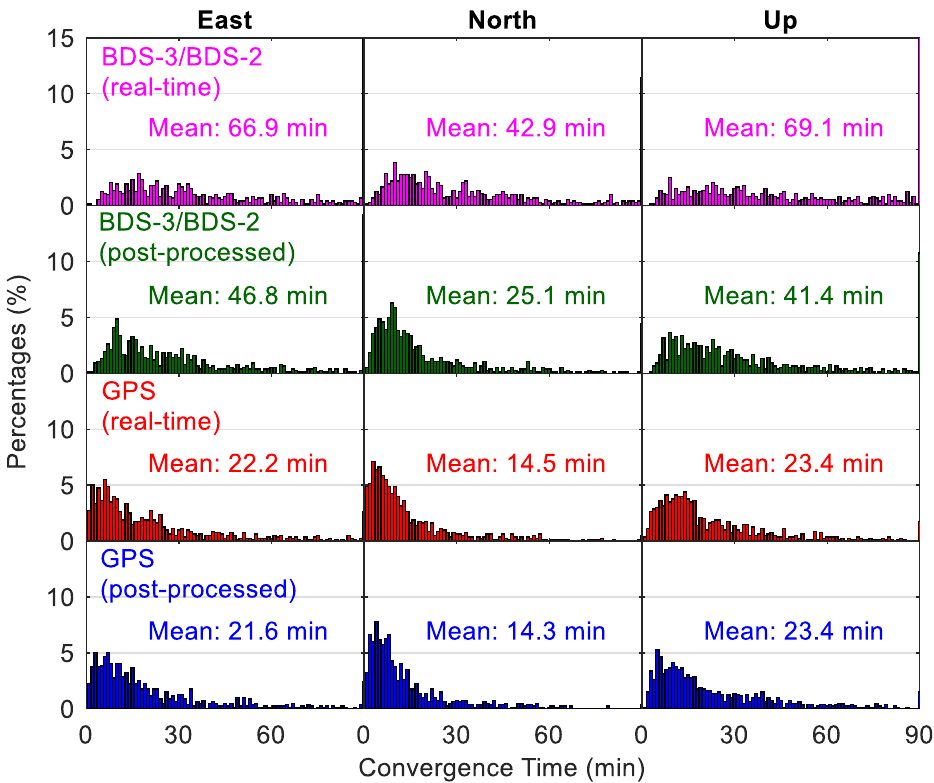
Figure 17. Distribution of convergence time from different kinematic PPP solutions.